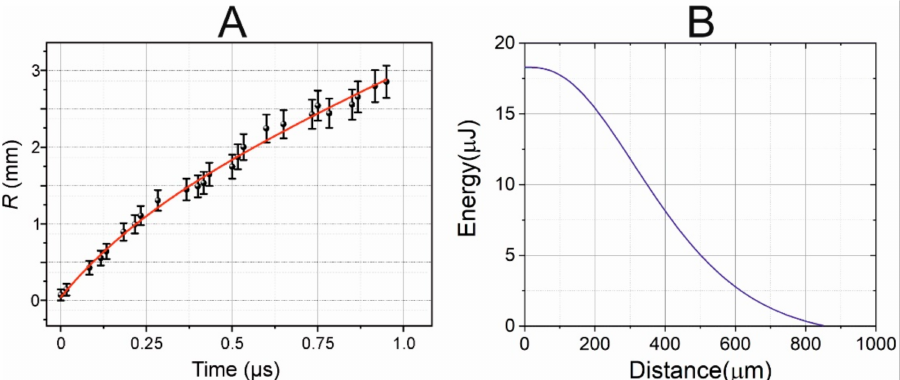
Figure 7. ( A ) Time variation in the shock wave radius in water under the impact of a laser pulse with a duration of τ = 8 ns and an energy of E = 68 µ J on the absorbing Ti layer in Configuration 2 (Figure 1B). The red curve shows the trend for the exponentially decaying shock wave. ( B ) Dependence of shock wave energy on the distance from its